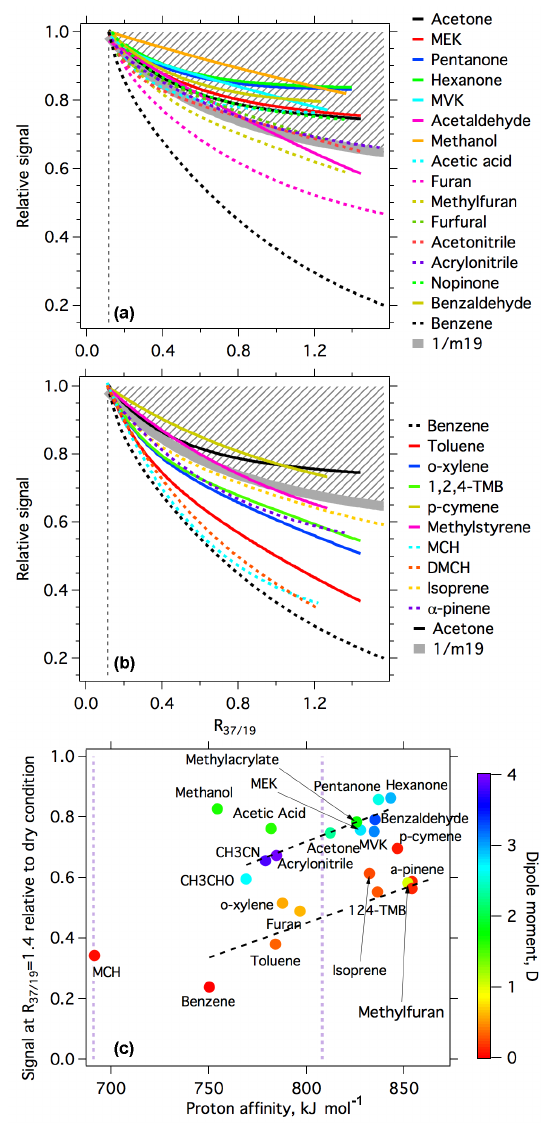
Figure 5. Derived humidity dependence curves for the normalized signals relative to dry conditions as a function of R 37 / 19 ratios for oxygenates (a) and hydrocarbons (b) , respectively. The humidity- dependent curves of benzene and acetone are shown in both (a) and (b) . The thick gray lines indicate the reciprocal of the H 3 O + (cid:16) 1 (cid:17) signal relative to dry conditions . Vertical dashed lines in (a) m 19 and (b) indicate the level of R 37 / 19 under dry conditions. (b) Nor- malized signals at R 37 / 19 = 1.4 (equivalent to RH = 90% at 25 ◦ C) relative to dry conditions for different VOC species as a function of their proton affinities. Data points are color-coded using the perma- nent dipole moment of the species. The two purple vertical dashed lines are proton affinities of water and water dimer, respectively. The two black dashed lines indicate the linear fits to the species with permanent dipole moment larger than 1 ( y = − 1 . 30 + 2 . 52 × 10 − 3 × PA) and lower than 1 ( y = − 1 . 38 + 2 . 29 × 10 − 3 × PA), re-